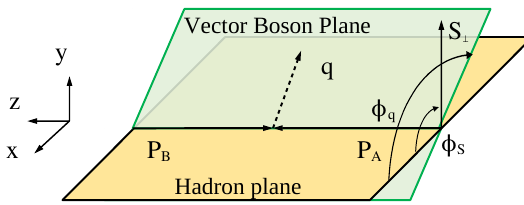
Figure 2 . Illustration of Drell-Yan vector boson production in collisions of hadrons A and B . The transversely polarized hadron A is moving in + z -direction, while the unpolarized hadron B is along − z -direction. We denote the vector boson using a dotted